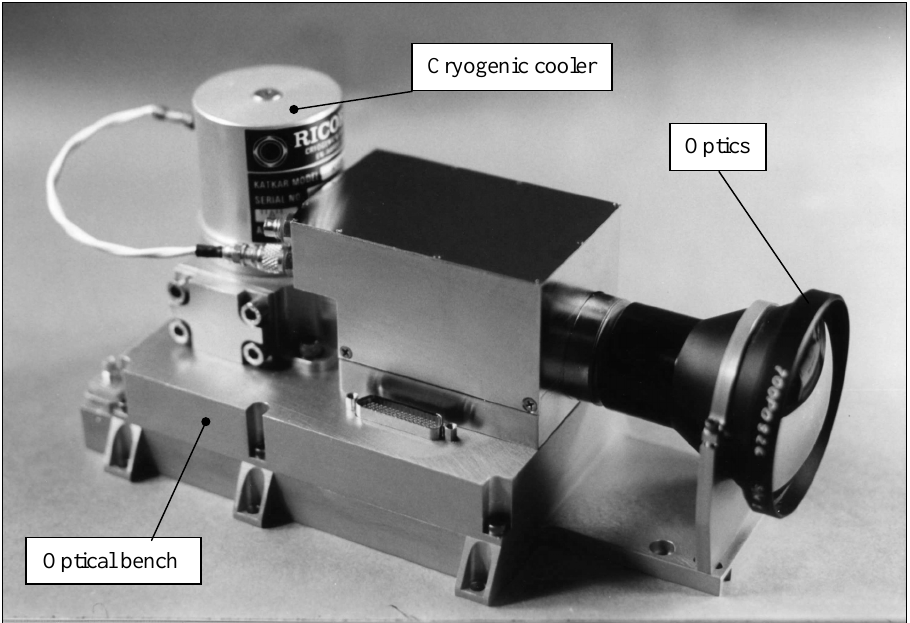
Fig. 3. Typical electro-optic